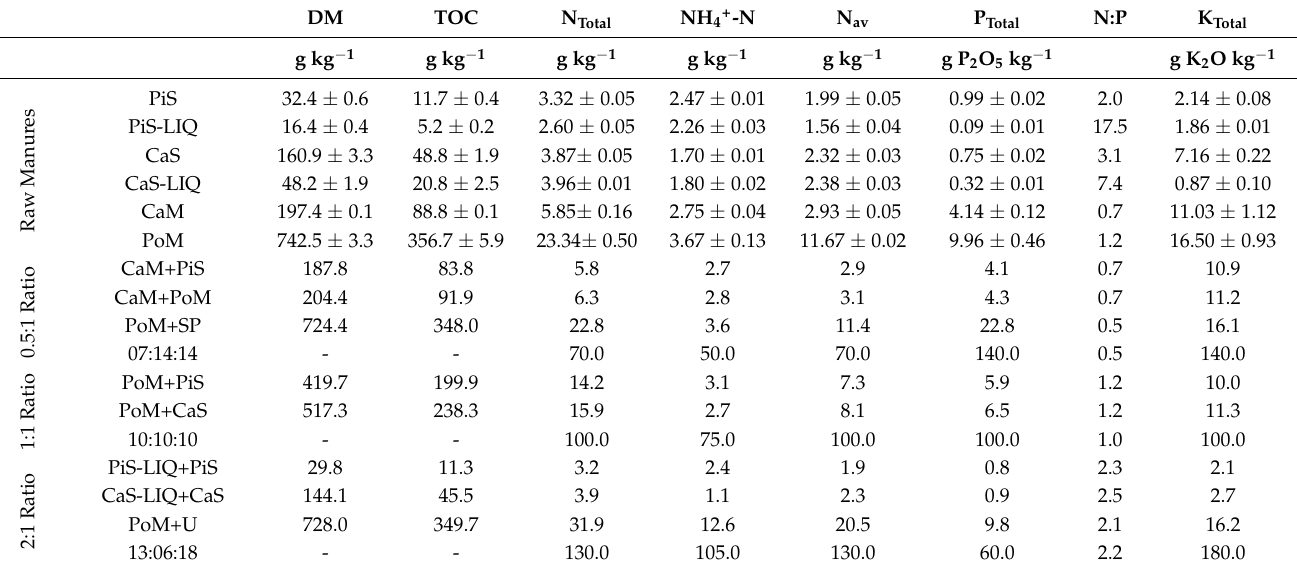
Table 1. Physicochemicalcharacteristicsoftherawmanuresconsideredinthestudy(meanvalue ± standard deviation, n = 3). The composition of each manure-based fertilizer was calculated to provide the desired N:P ratios, and the nutrients’ concentrations and ratios were calculated considering the values of the raw manure and derived fractions. All concentrations were expressed on a fresh matter